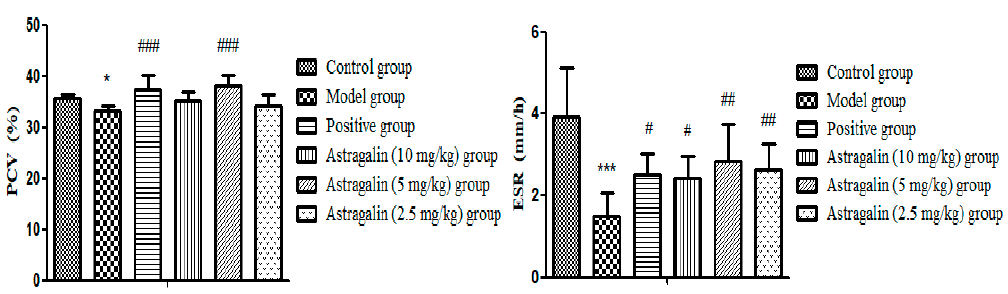
Figure 9. Effects of Astragalin on ESR and PCV (X ± SD, n = 8). Compared with the control group: